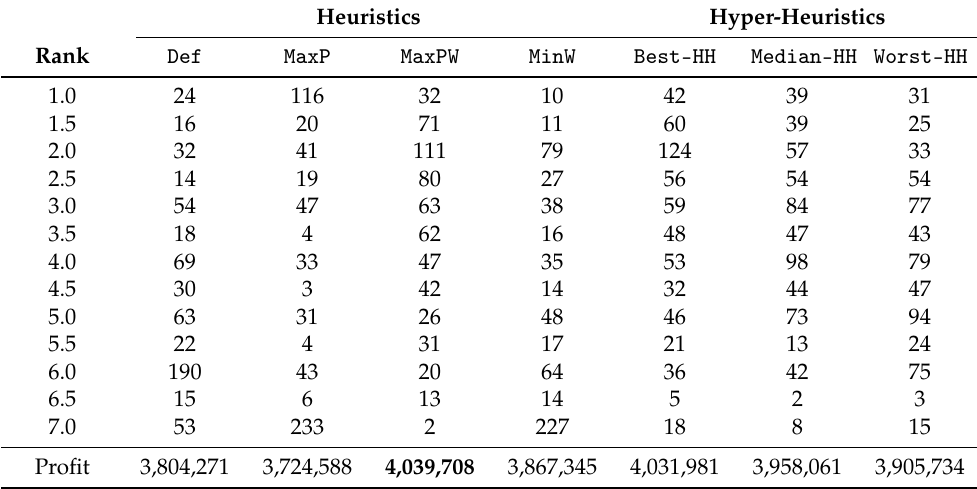
Table 7. Ranks and total profit obtained by the four heuristics and the best, median, and worst hyper-heuristics trained on set α 1 and tested on set β 1 . The best result, measured in terms of total profit, is highlighted in